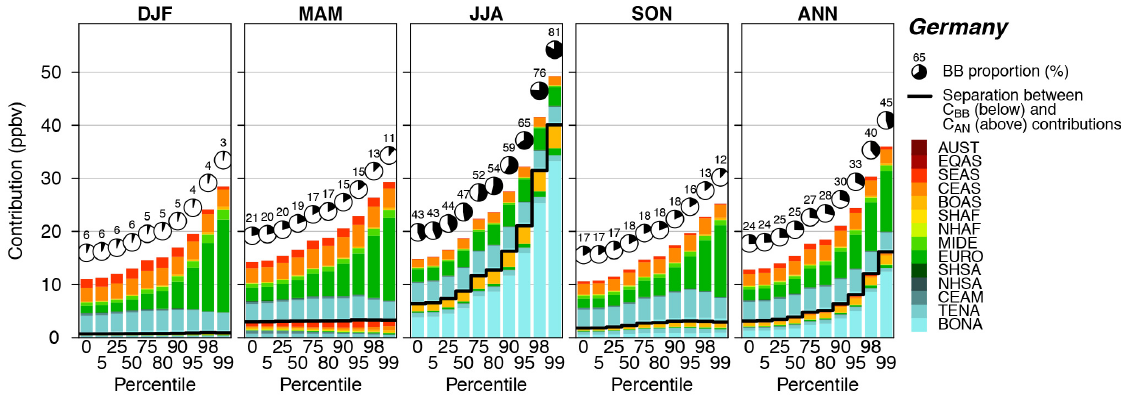
Figure 16. Mean total (C AN + BB ) contributions to CO anomalies at the Germany airport cluster. Results are shown for all seasons and different anomaly subsets (designated by the corresponding percentile). The geographic origin of both types of CO emissions is indicated by the colours. The dark line separates the C BB (below) and C AN (above) contributions. The relative contribution of BB in the total (AN plus BB) primary contribution is indicated with a pie chart and the corresponding figure.